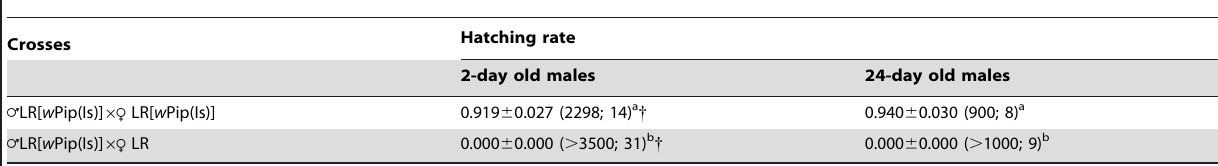
2-day old males 24-day old males